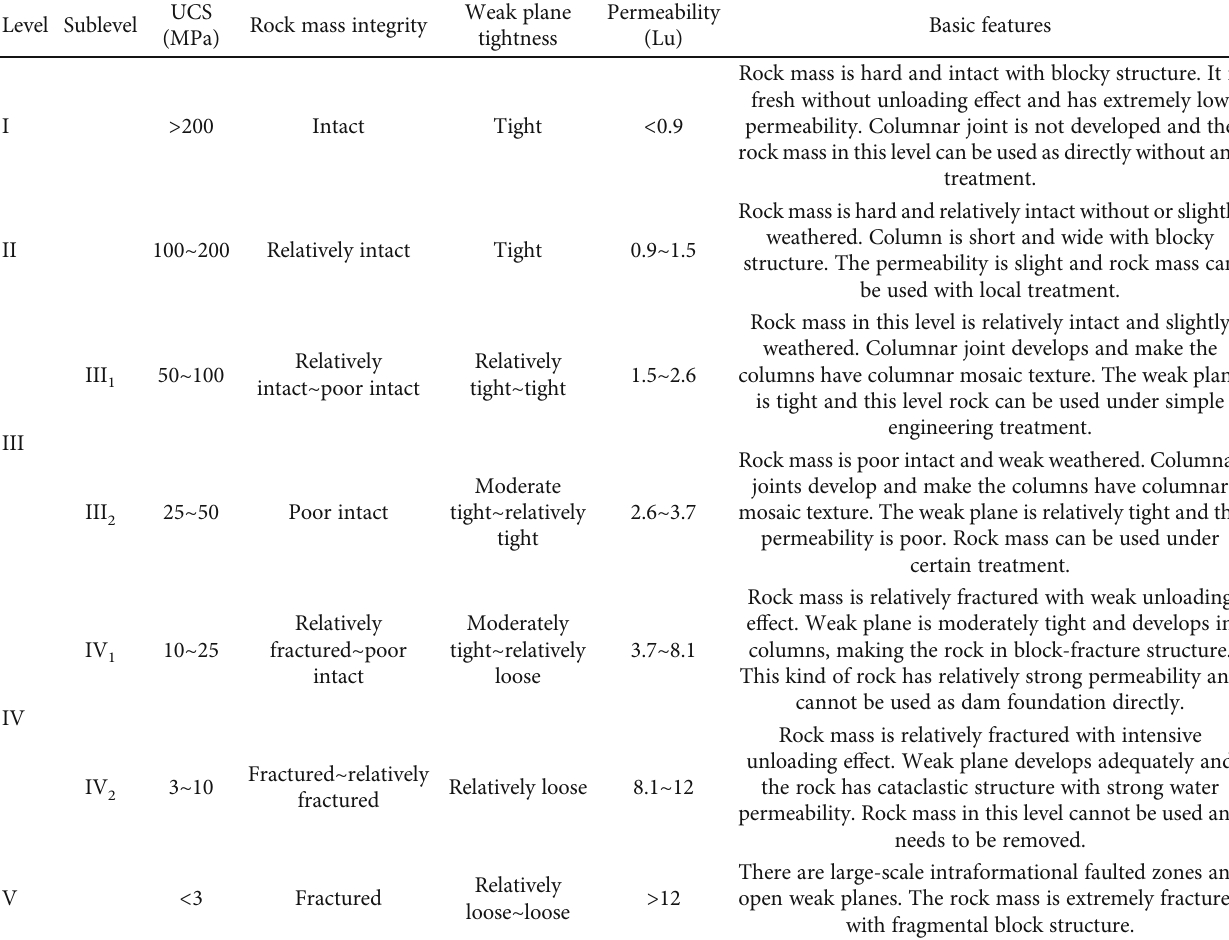
Table 7: Columnar jointed rock classi fi cation